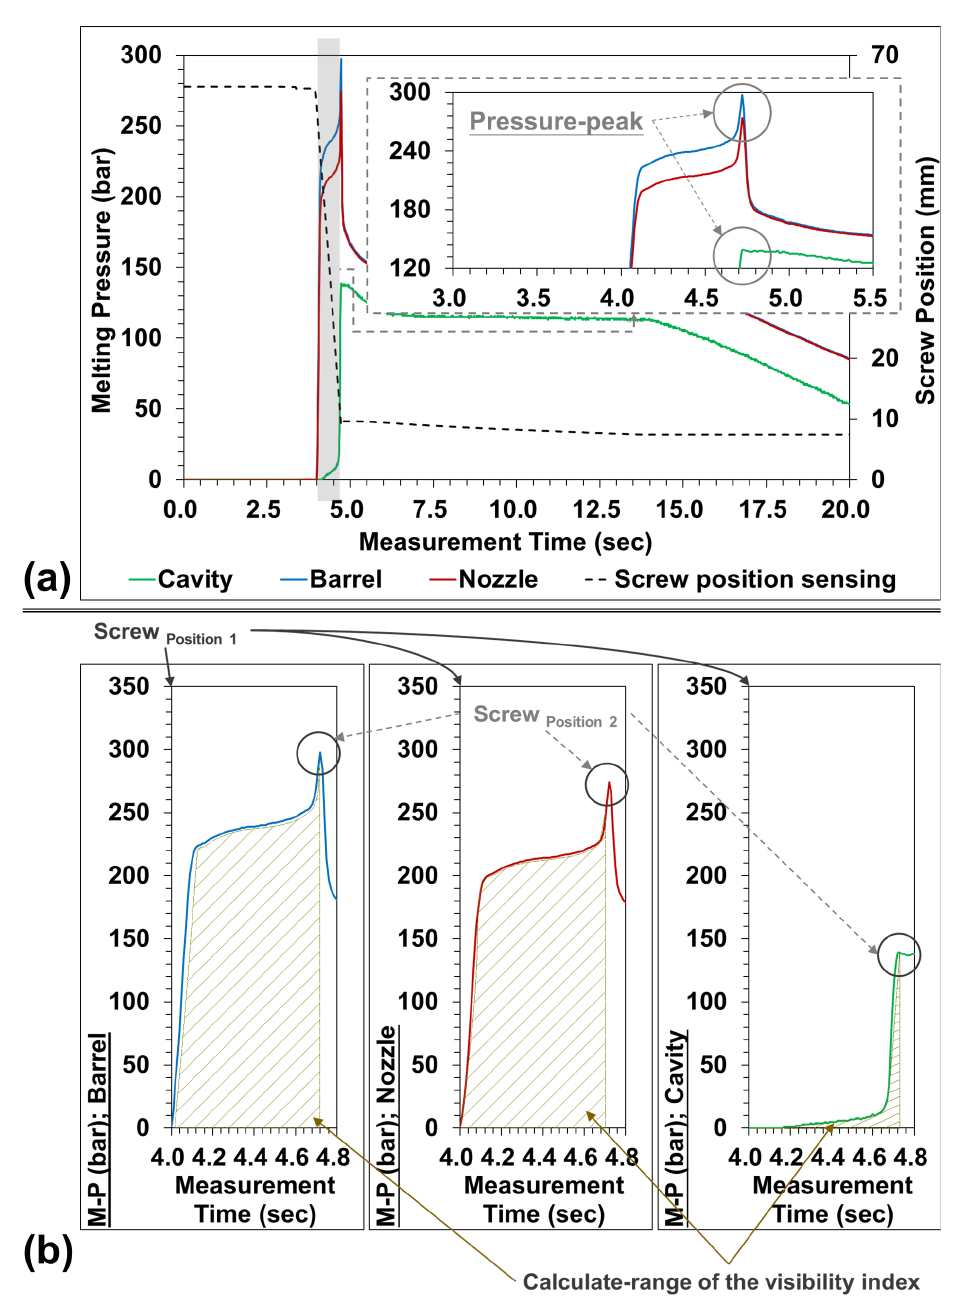
Figure 7. Melting pressure and viscosity index calculation: ( a ) melting pressure measurement; ( b ) calculation of the viscosity index.